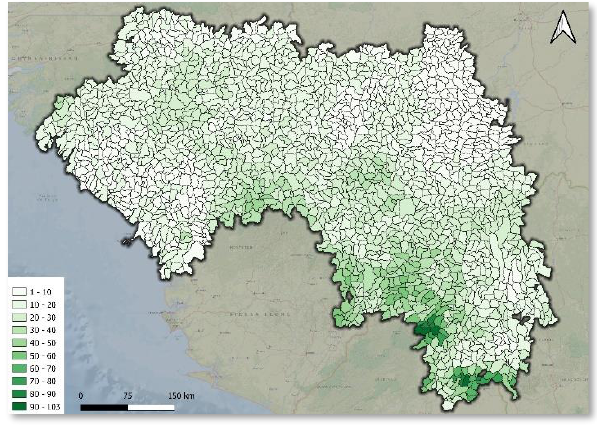
Figure 8. Carbon in living above-ground biomass in 2015 (t/ha) Based on data from the International Soil Reference